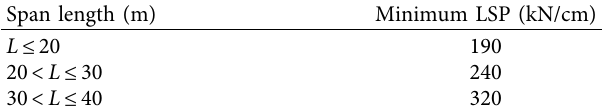
Table 1: Suggested values of LSP in the current code. Span length (m)